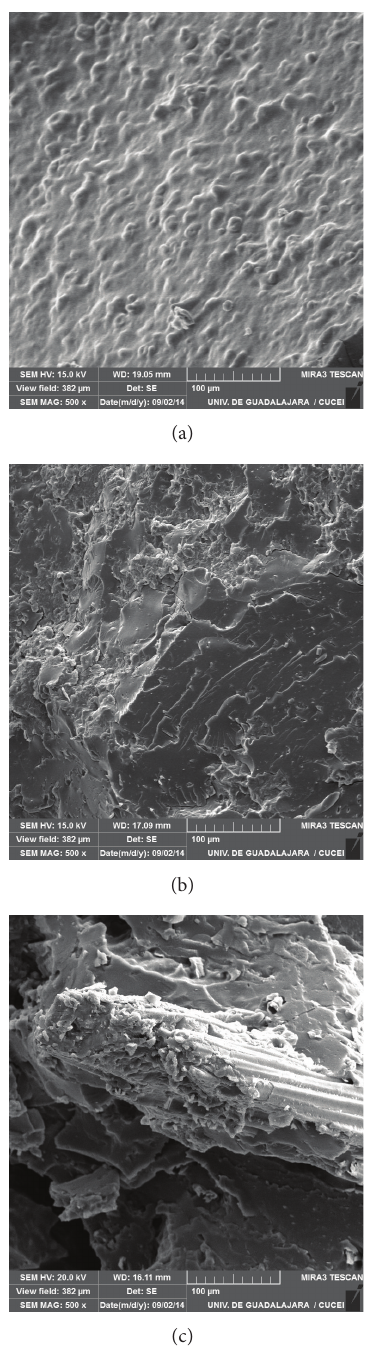
Figure 10: SEM images of polymeric materials: (a) TPS, (b) polymer blend containing 20wt% PLA, and (c) 80 TPS/20 PLA w/w, with 15 wt% ABF